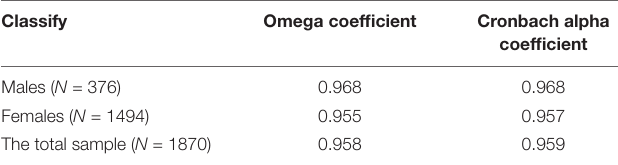
TABLE 9 | Omega coefficients and Cronbach alpha coefficient of participants.